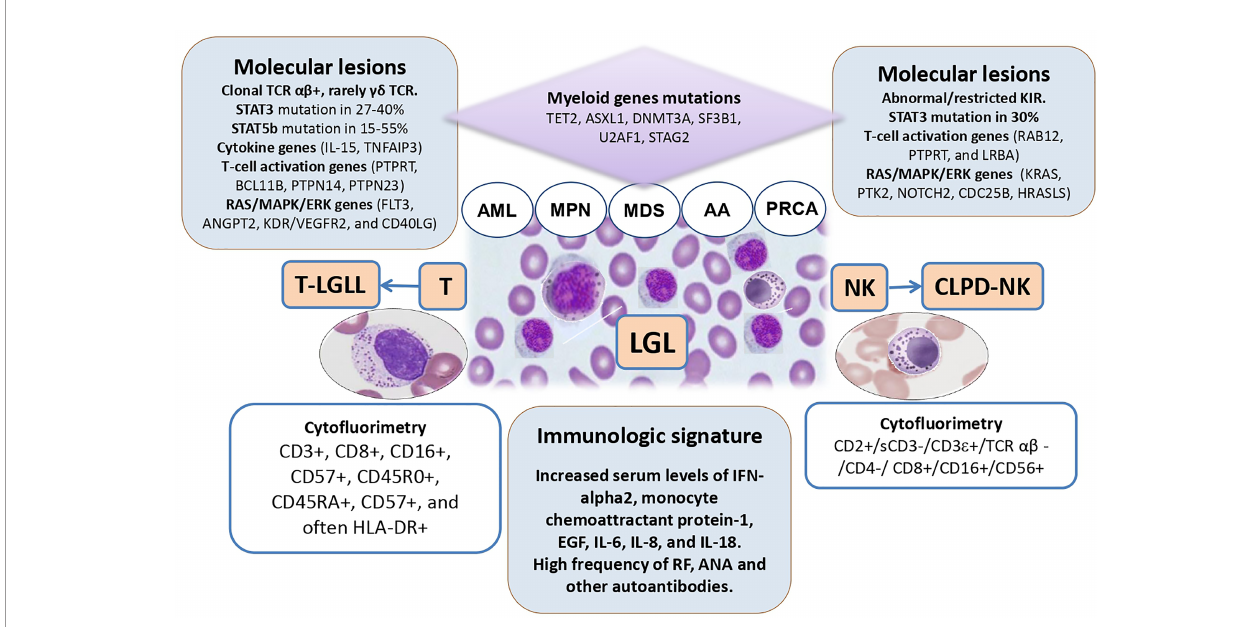
FIGURE 1 | The intersections among large granular lymphocyte (LGL) disorders and myeloid neoplasms. TCR, T-cell receptor; AML, acute myeloid leukemia; MPN, myeloproliferative neoplasm; MDS, myelodysplastic syndromes; AA, aplastic anemia; PRCA, pure red cell aplasia; NK, natural killer cells; T-LGLL, T-cell large granular lymphocyte leukemia; CLPD-NK, chronic lymphoproliferative disorder of NK-cells; IL,